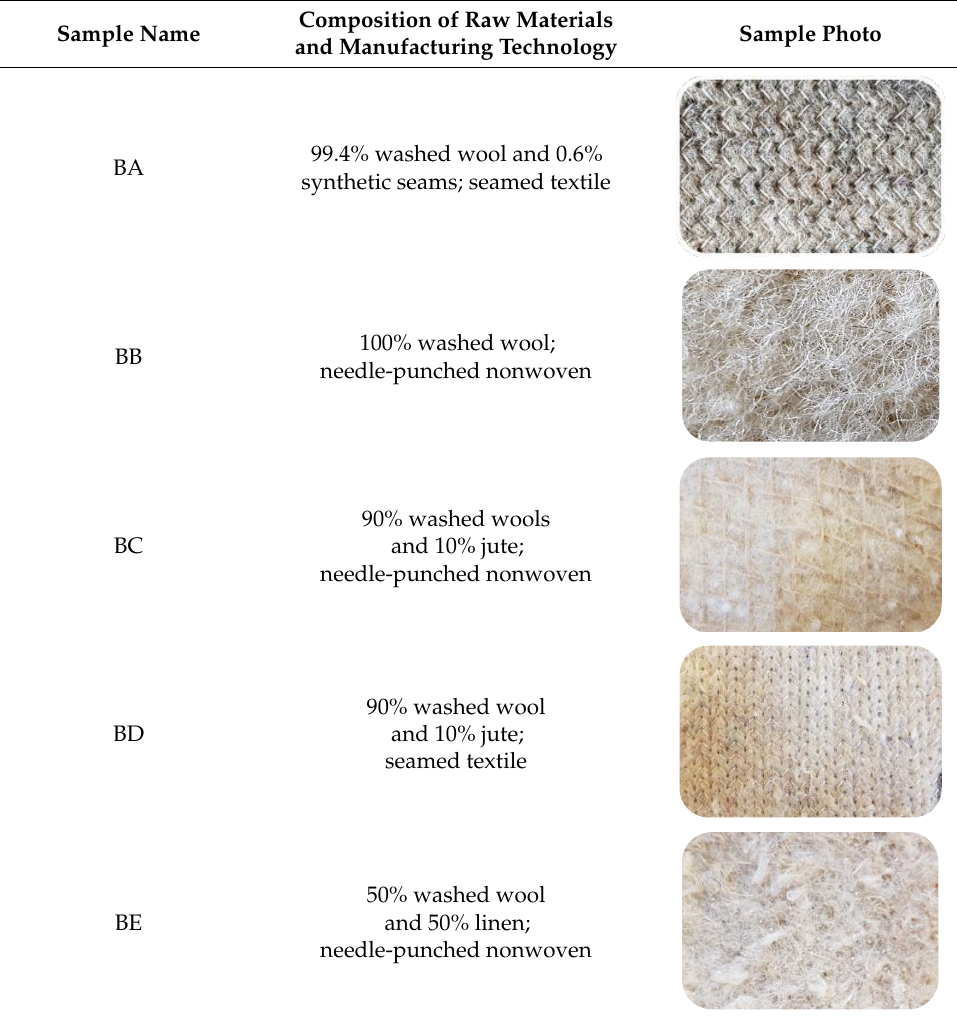
Table 1. Attributes of the analysed materials.